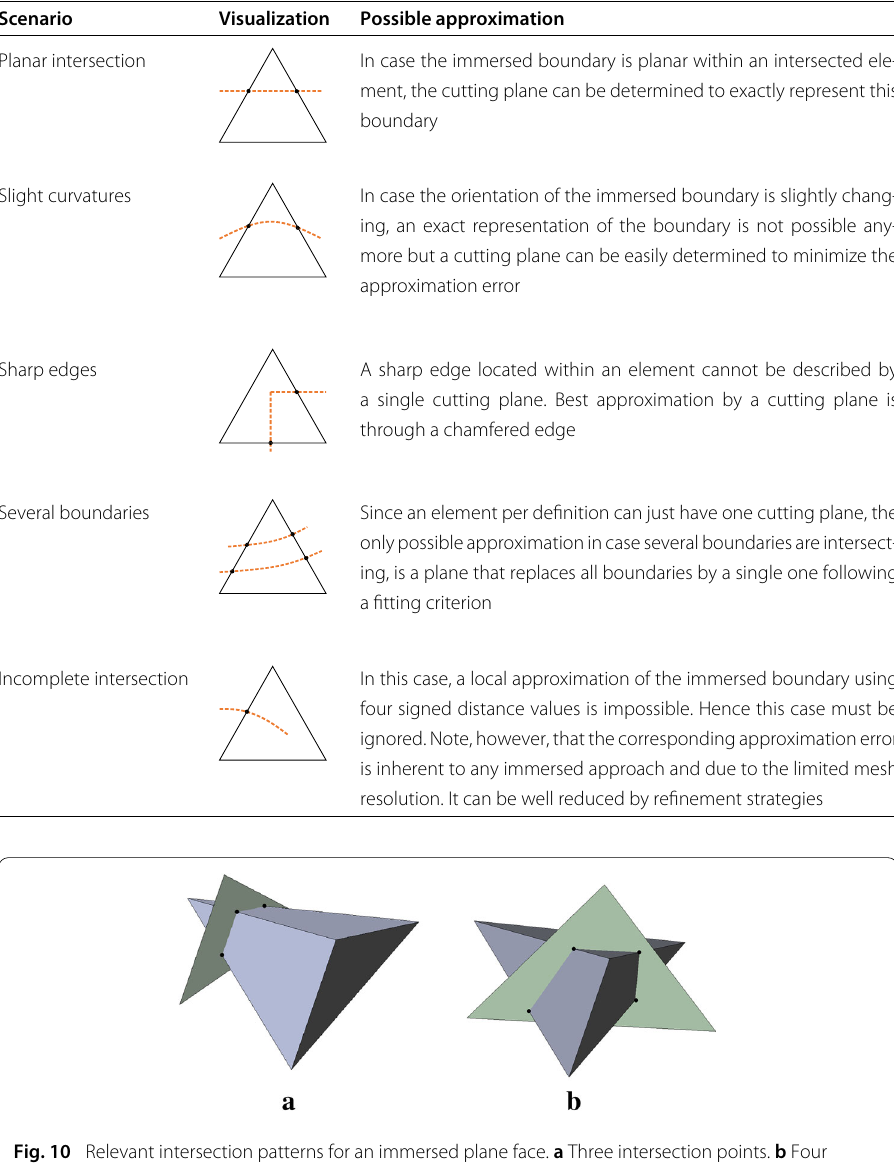
Approximation of curved